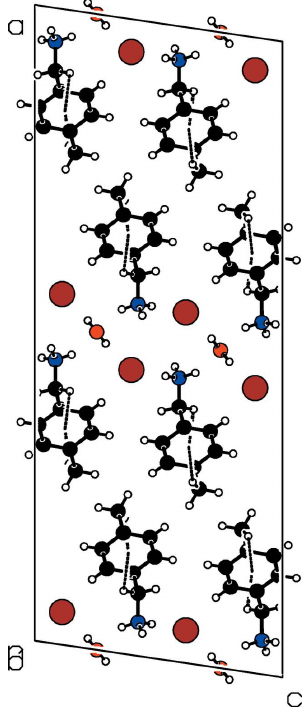
Figure 3 A partial packing diagram of (I), viewed down the b axis, showing the